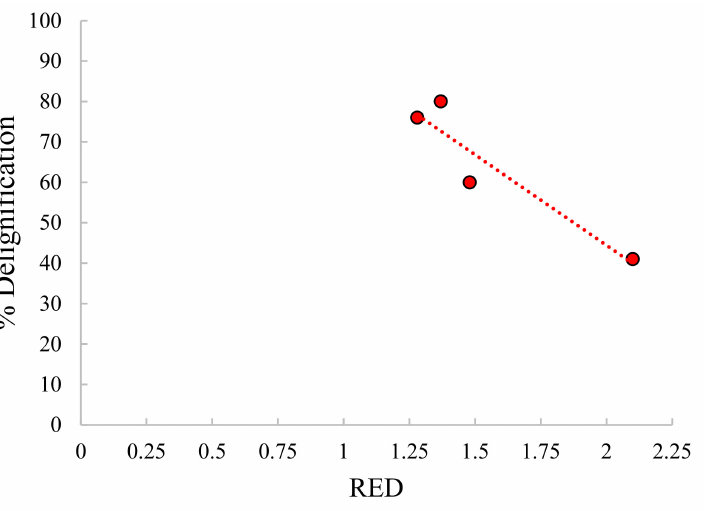
Figure 9. Relative Energy Difference (RED) for solvation of Kraft lignin in different solvent mixtures. Monomeric products present in the organic phase were quantified with GC (Figure